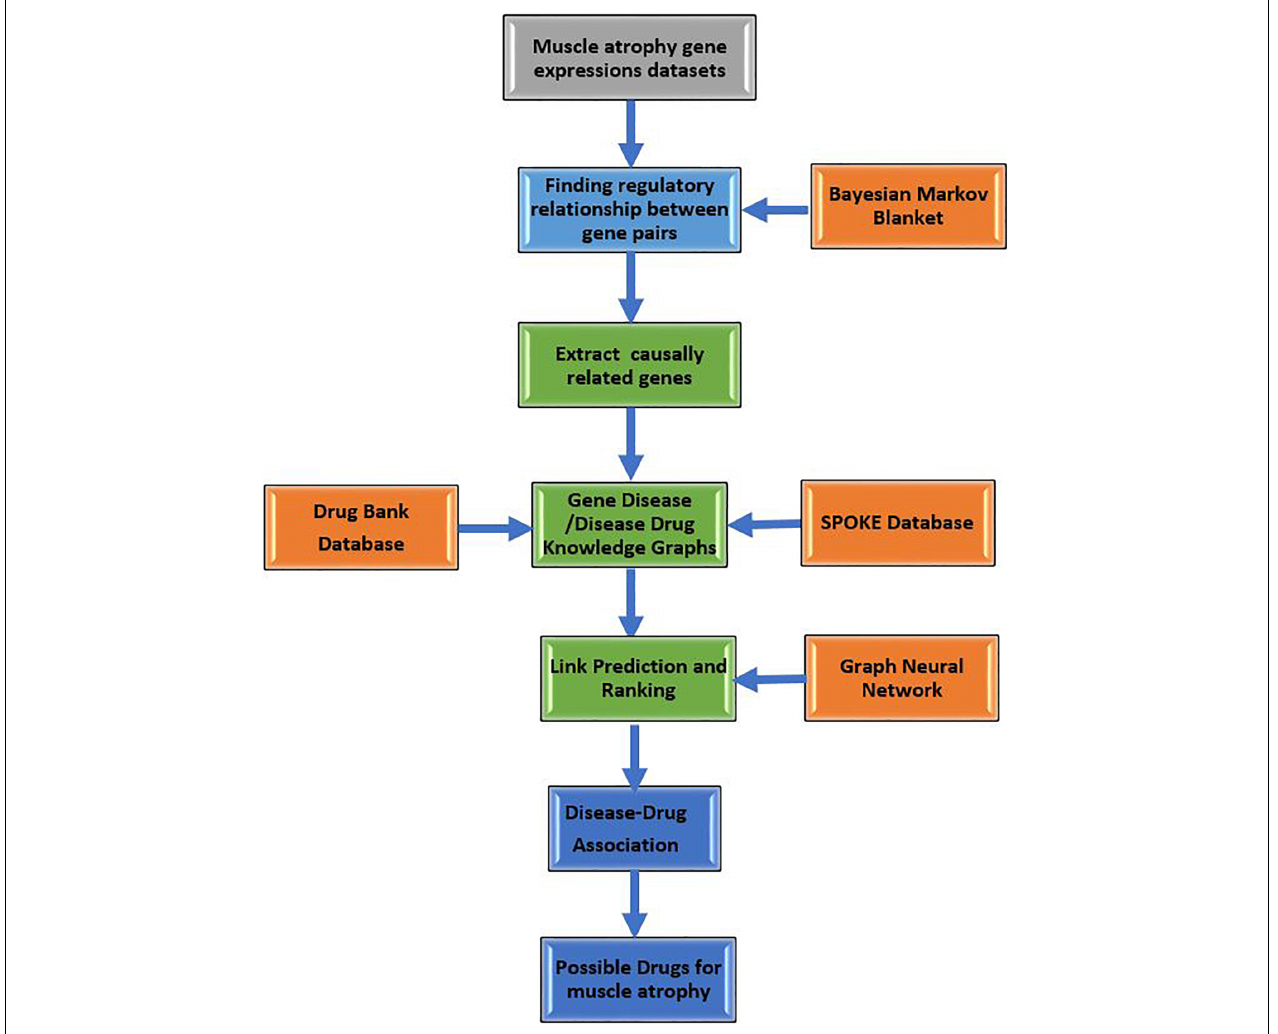
FIGURE 1 | Flow diagram showing sequence of steps followed for constructing GDKG, DDKG, and link prediction for drug repurposing to treat muscle atrophy in spaceflight microgravity.